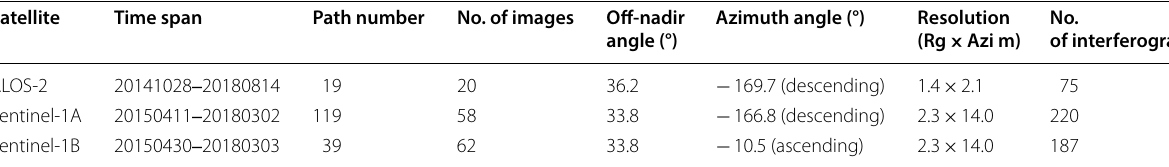
Table 1 SAR data used in this study Satellite